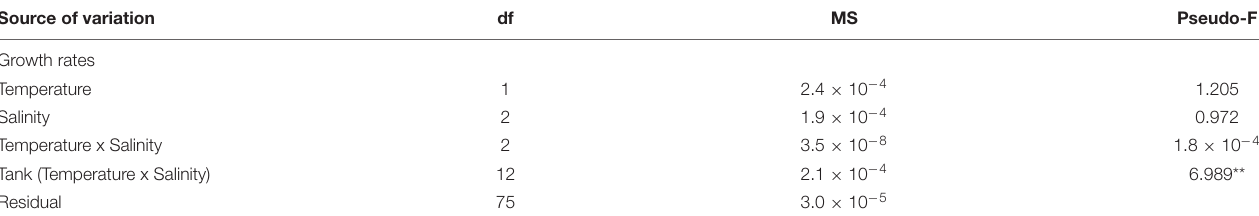
TABLE 3 | Results of the permutational analysis of variance (PERMANOVA) investigating the effects of salinity and temperature on the growth rates of juvenile Solea senegalensis . Source of variation df MS